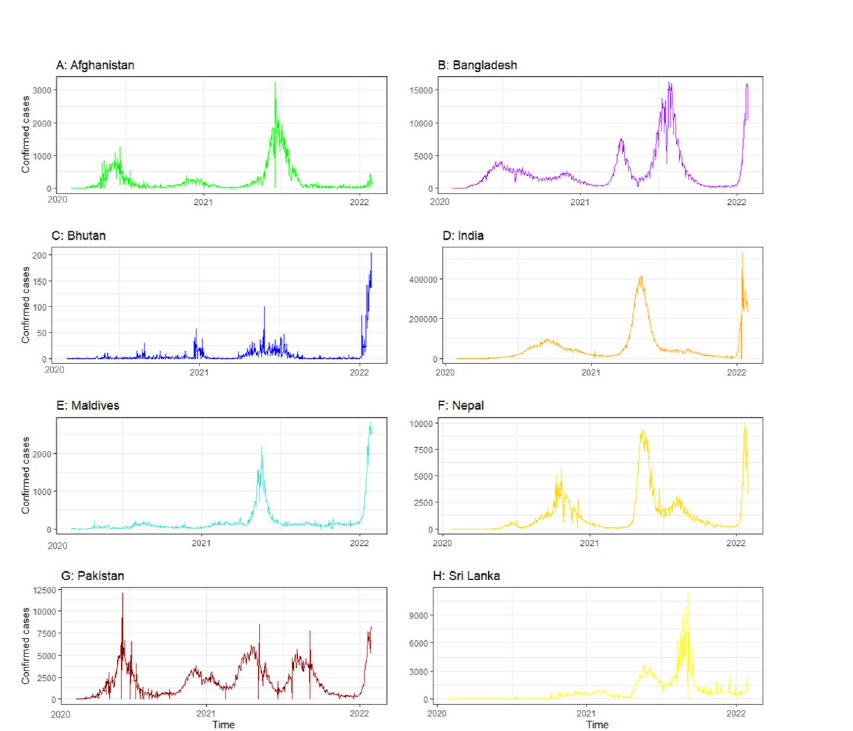
Fig 3. Time series plot showing the trend of COVID-19 confirmed cases for SAARC countries.